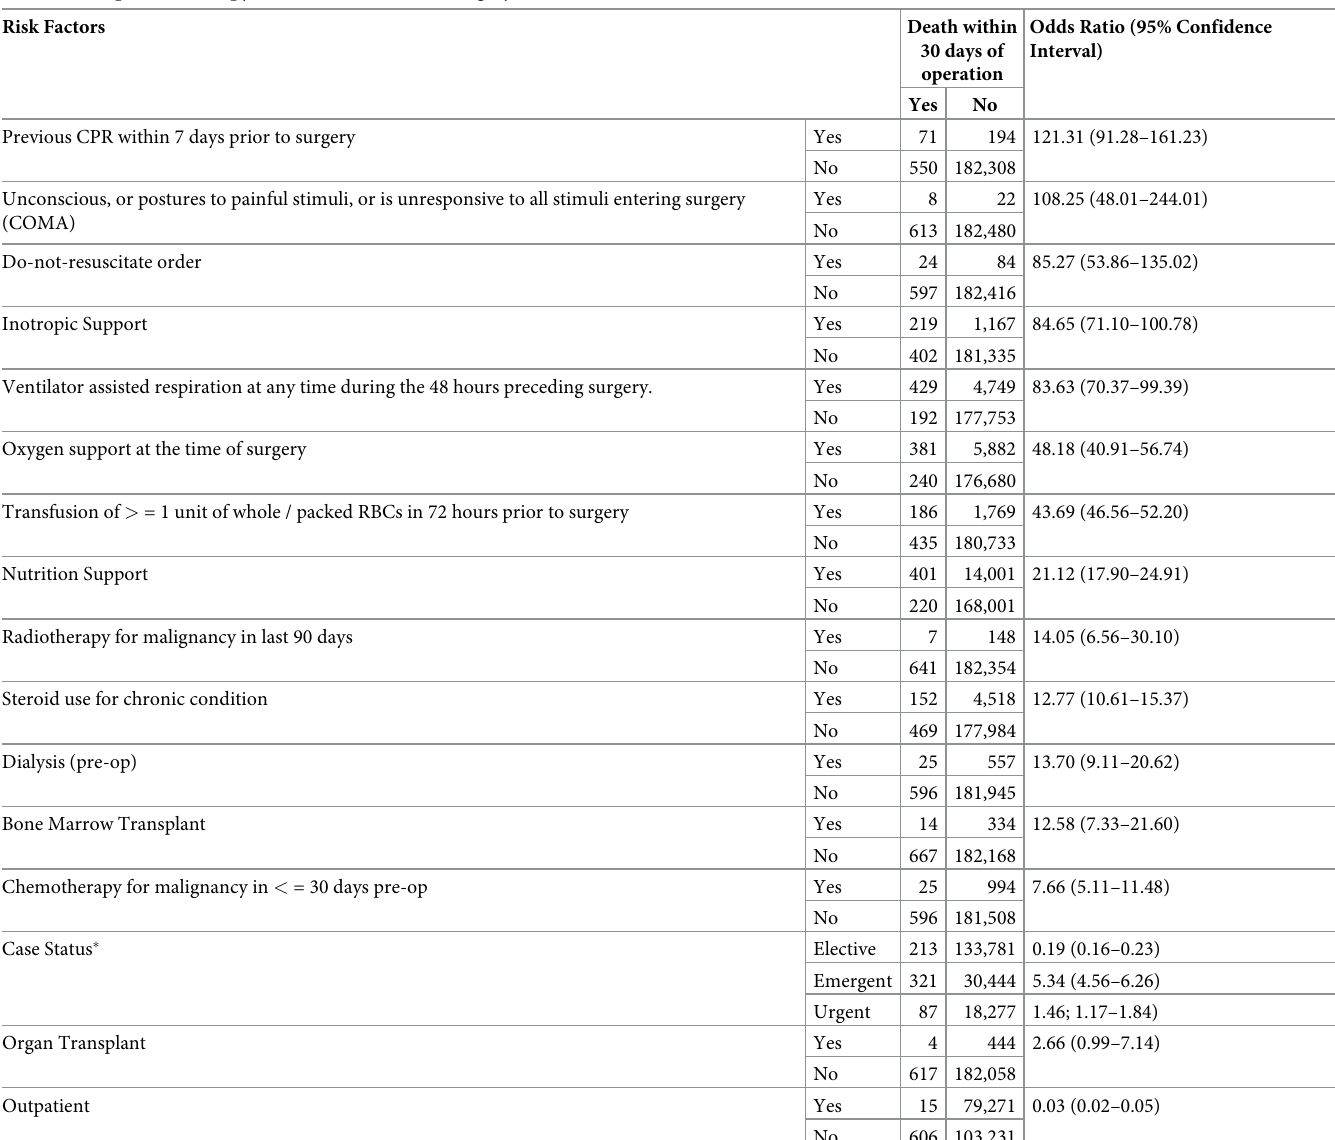
Table 3. Preoperative therapy and risk for death after